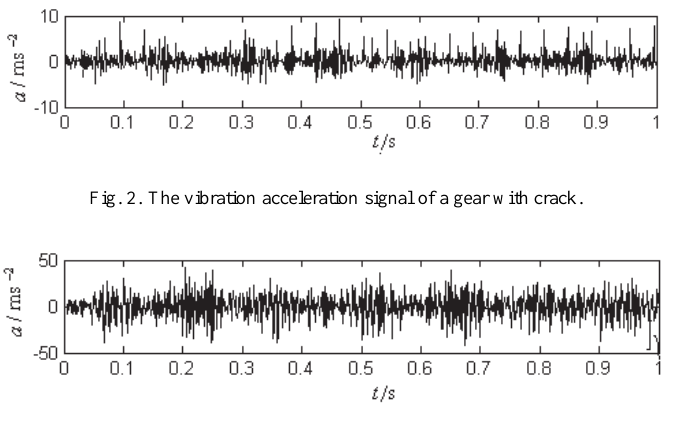
Fig. 3. The vibration acceleration signal of a gear with broken tooth.